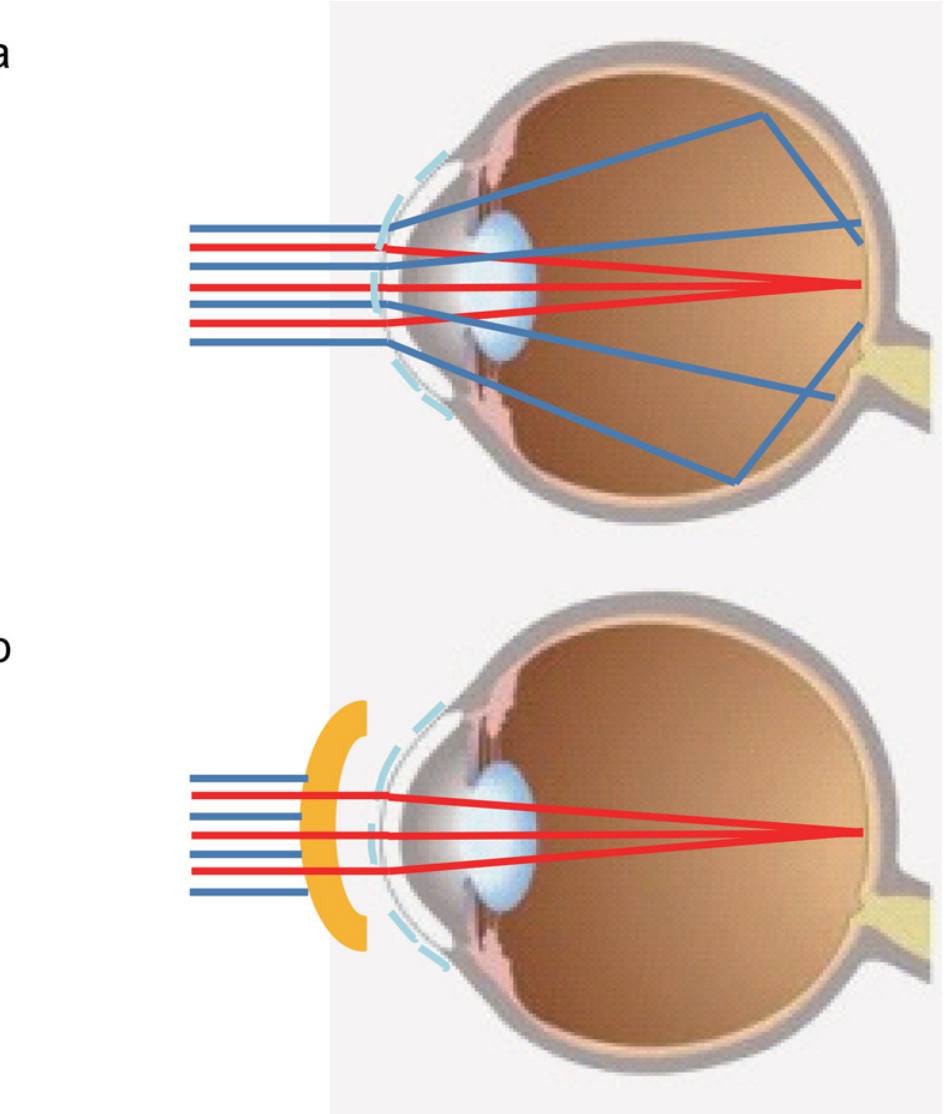
Fig 4. Mechanism of the effect of the blue light blocked lens on visual function. Red and blue lines represent red and blue light, respectively. a. Unstable tear film without blue light blocked lens. The blue light is scattering. b. Unstable tear film with blue light blocked lens. The lens is blocking the blue